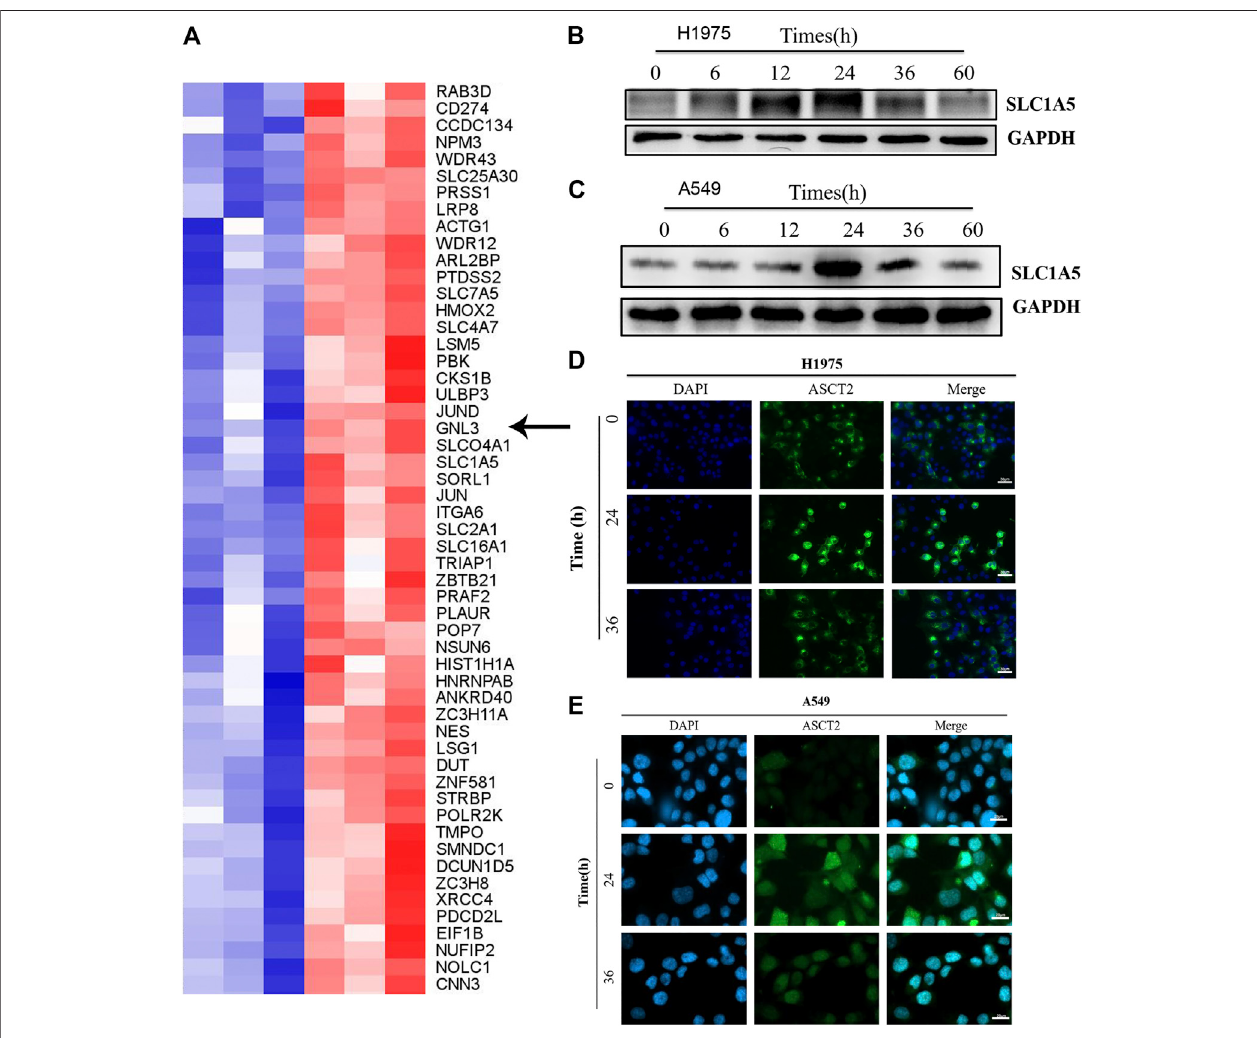
FIGURE2| ASCT2(SLC1A5) proteinexpressionwasup-regulatedinAlmonertinib-inducedenergymetabolictransportchannels. (A) AfterstimulatingH1975cells with Almonertinib at IC50/2 (4 µM) for 18 h, the cells were collected and LC-MS was used to analysis differences in the expression of related proteins. The arrow shows the glutamine transporter SLC1A5. (B,C) Western blotting (WB) was used to examine the expression of SLC1A5 protein in H1975 cells stimulated by Almonertinib at different times. (D,E) Immuno fl uorescence was used to detect the expression of SLC1A5 protein in H1975 cells stimulated by Almonertinib at different